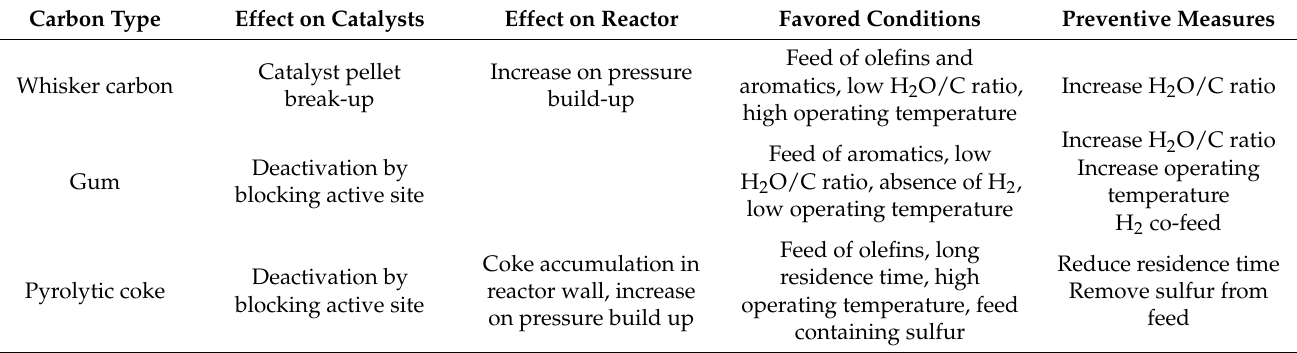
Table 1. Types of carbon formed during reforming reactions, their effects and critical conditions favoring the